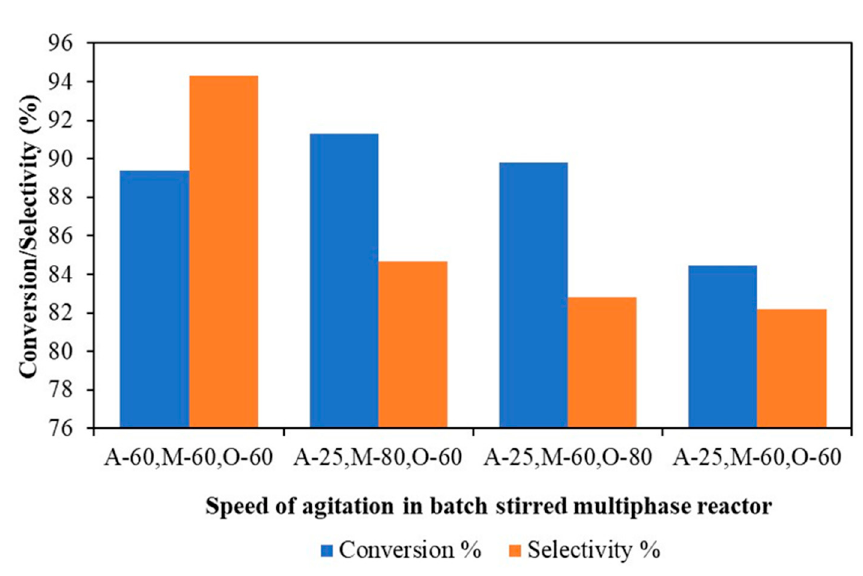
Figure 4. Effect of the speed of agitation in batch stirred multiphase reactor. Epichlorohydrin 0.1 mol, n-decane 0.03 mol, toluene 150 cm 3 , guaiacol 0.1 mol, sodium hydroxide 0.2 mol, sodium chloride 0.6 mol, tetra-n-butylammonium bromide 0.14 mol, and water 150 cm 3 . Temperature 40 °C, A—speed of agitation of lower aqueous phase, M—speed of agitation of middle catalyst phase, O—speed of agitation of upper organic phase, reaction time 6 h.